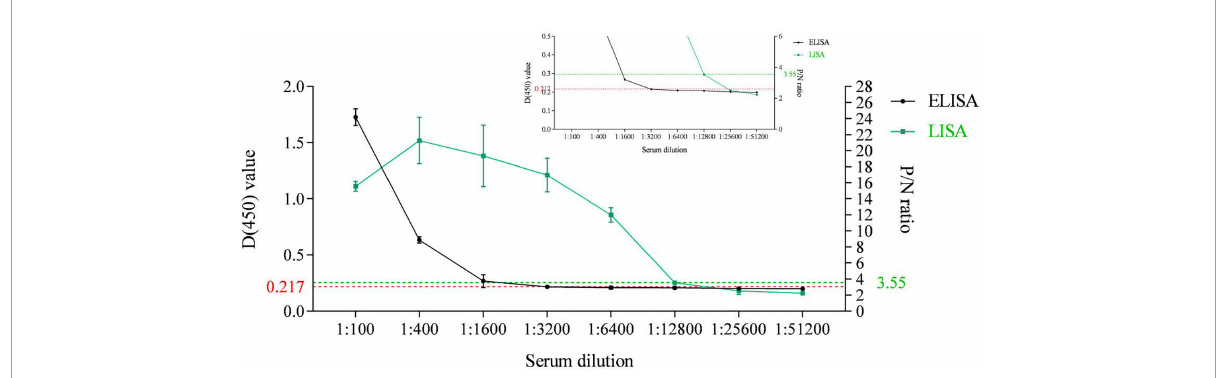
FIGURE5 Sensitivity comparison between the p35-Luc LISA (green line with squares) and the p35-ELISA kit (black line with dots) for anti-ASFV antibody detection. The ASFV-positive sera are diluted to different folds. The plots of the inset line charts show the signals under high dilutions, with dotted lines as the cutoff values for positive results. Data are shown with means ± SD. Error bars represent the standard deviations from